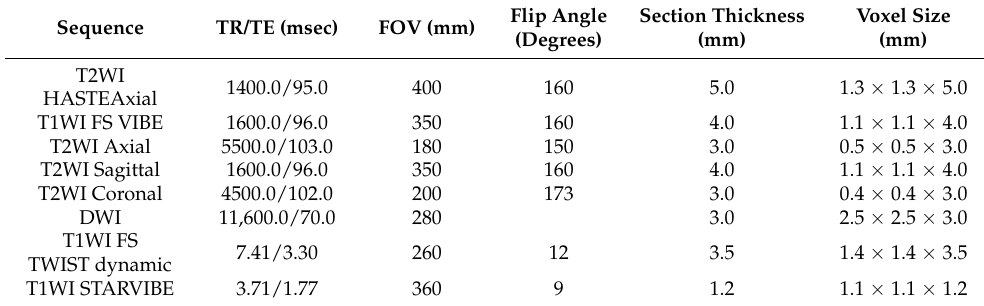
Table 6. Imaging parameters used for MRI.